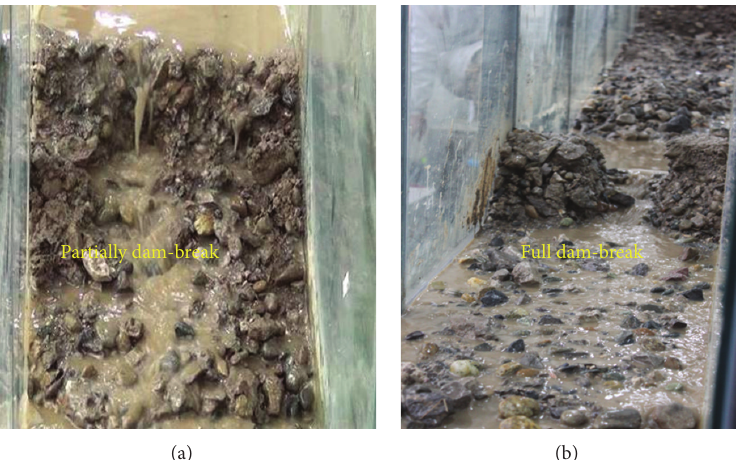
Figure 11: The results of Dam break experiments influenced by dam size: (a) top length of 26cm and (b) top length of 13cm.